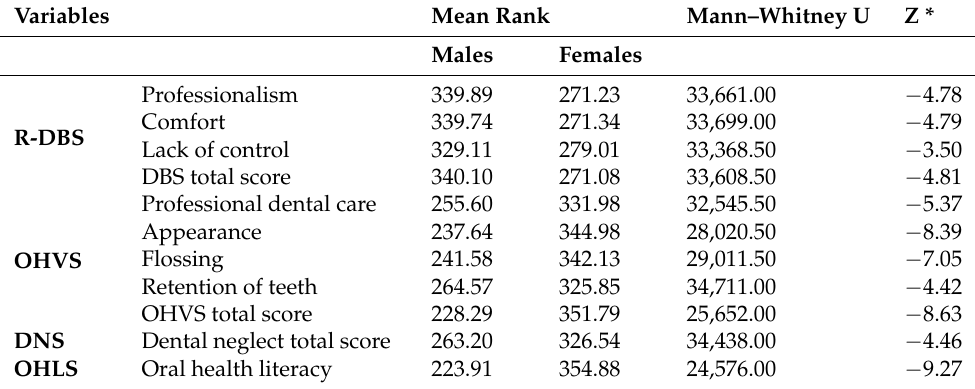
Table 3. Gender differences in oral health-related factors.